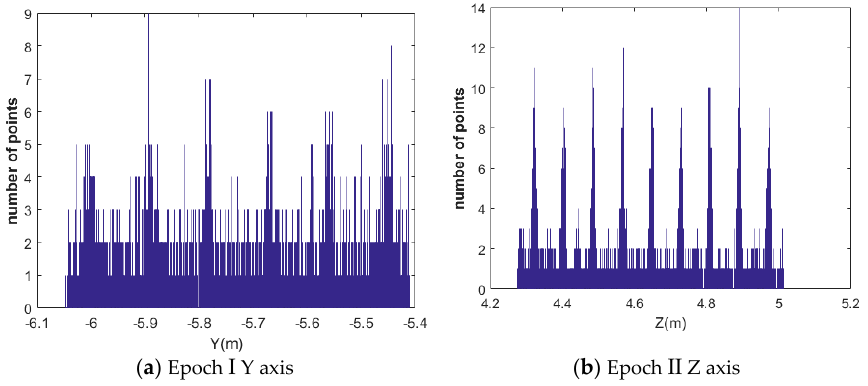
Figure 11. Histogram of mortar point frequencies along the Z and the Y axes.